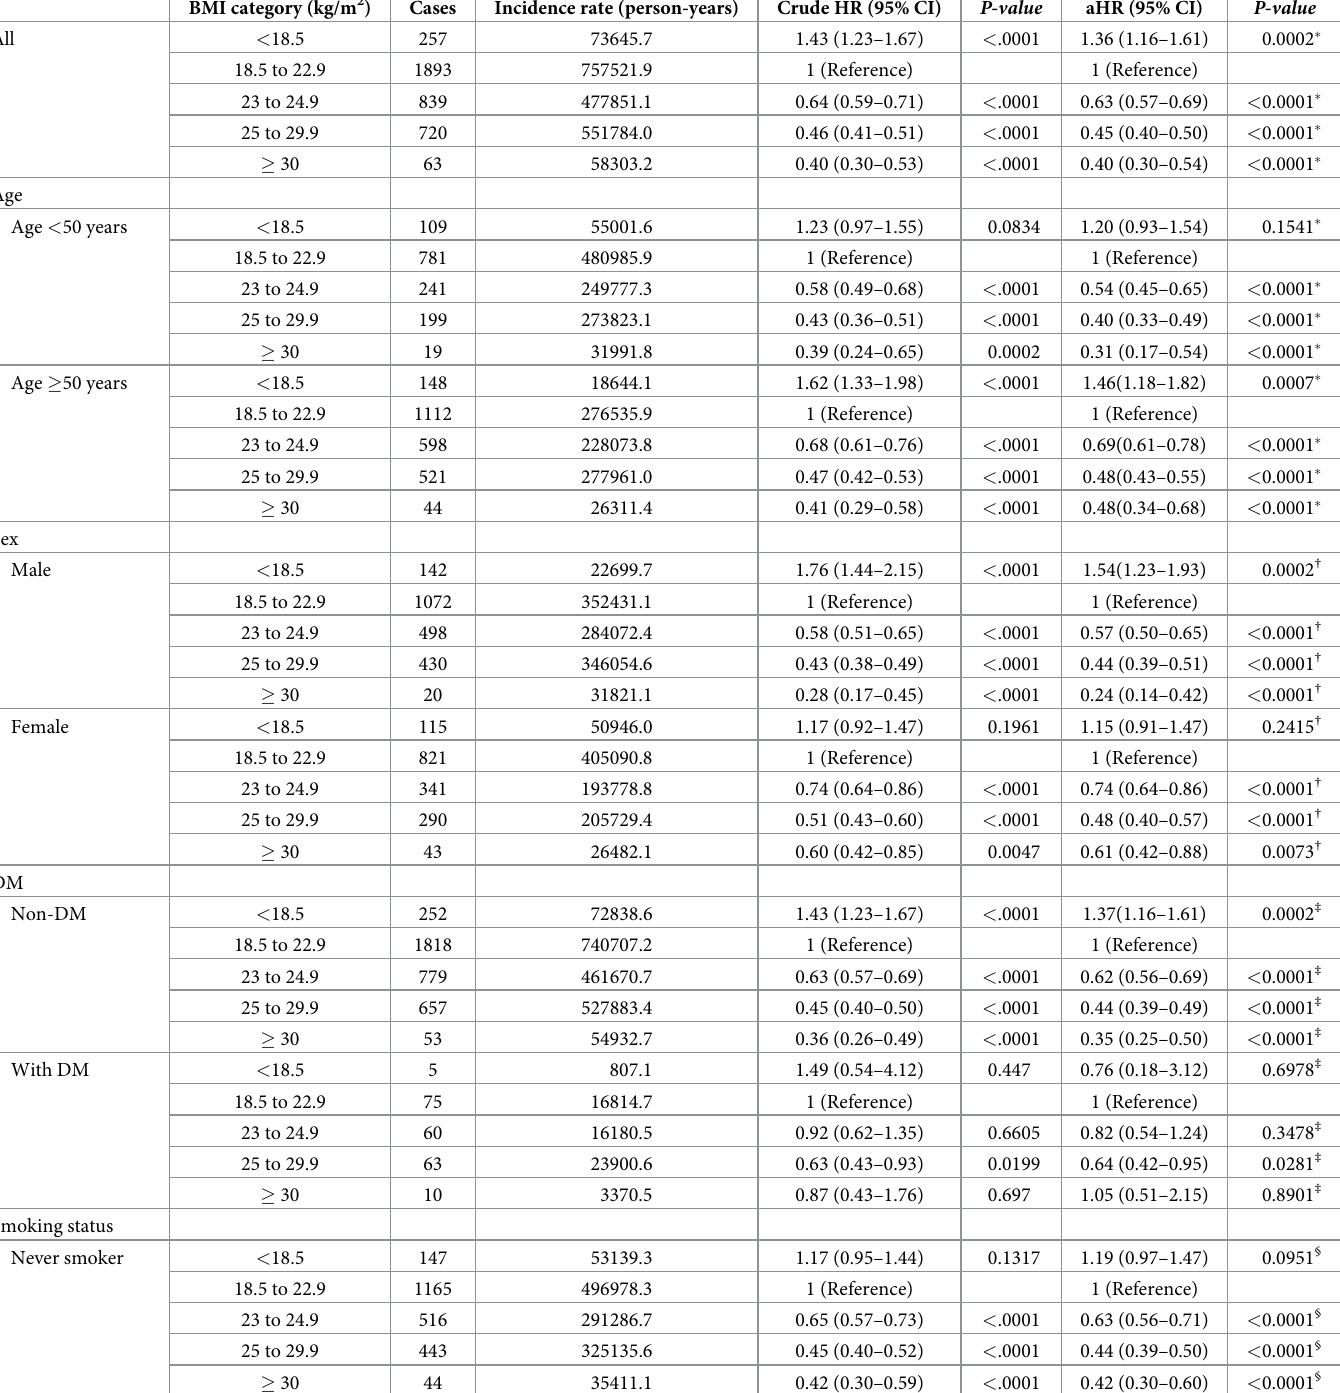
Table 2. Effect of BMI on development of tuberculosis and subgroup